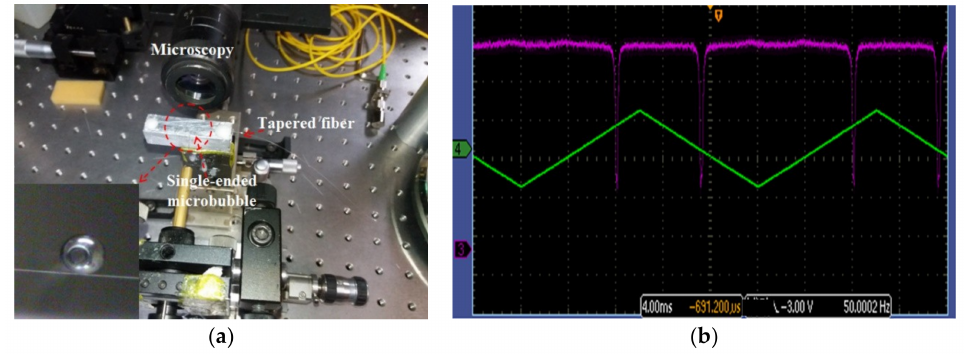
Figure 9. Experimental system and the output WGM spectrum. ( a ) Experimental setup of the WGM system; ( b ) screen shot of the output